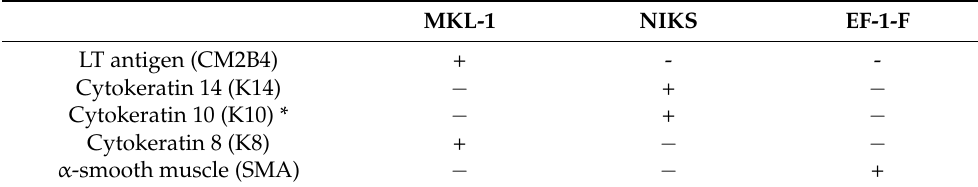
Table 1. Cell markers tested in immunofluorescent